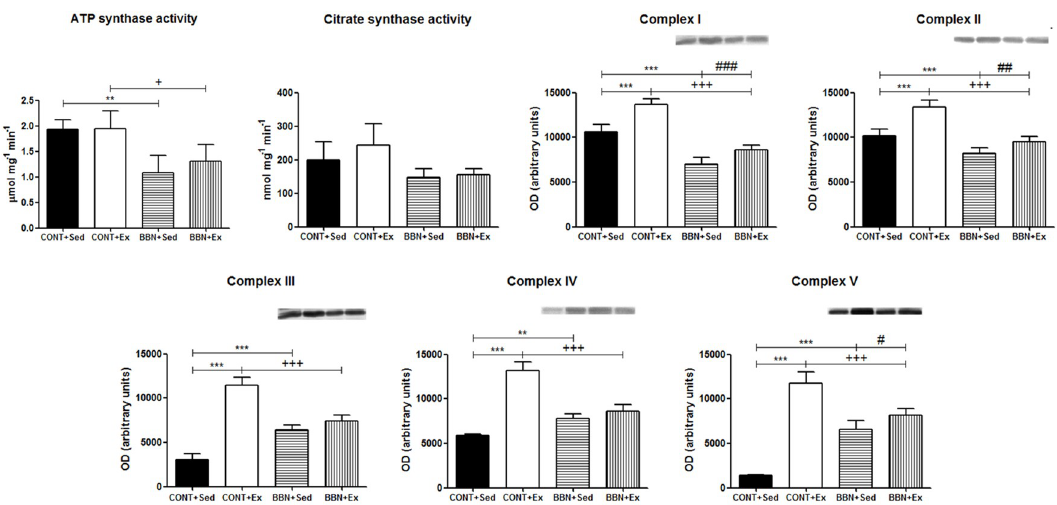
Figure 4. Effect of BBN exposure and/or exercise training on ATP synthase and citrate synthase activities, and on OXPHOS complexes subunits (complex I, CI-NDUFB8; complex II, CII-SDHB; complex III, CIII-UQCRC2; complex IV, CIV-MTCO1 and complex V, CV-ATP5A). Representative Western blots are shown above the correspondent graph (sample order has correspondence to the order of the groups presented in the graph). Values are expressed as mean ± standard deviation of n = 6 for BBN groups and n = 4 for CONT groups (** p < 0.01 vs. CONT+Sed; *** p < 0.001 vs. CONT+Sed; + p < 0.05 vs. CONT+Ex; +++ p < 0.001 vs. CONT+Ex; # p < 0.05 vs. BBN+Sed; ## p < 0.01 vs. BBN+Sed; ### p < 0.001 vs. BBN+Sed).